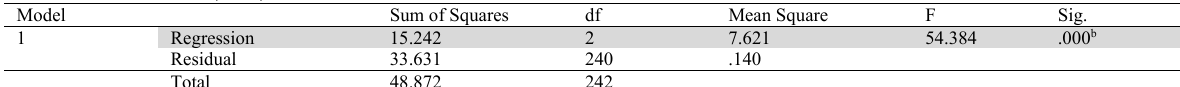
ANOVA between WS, OC, and WE Model